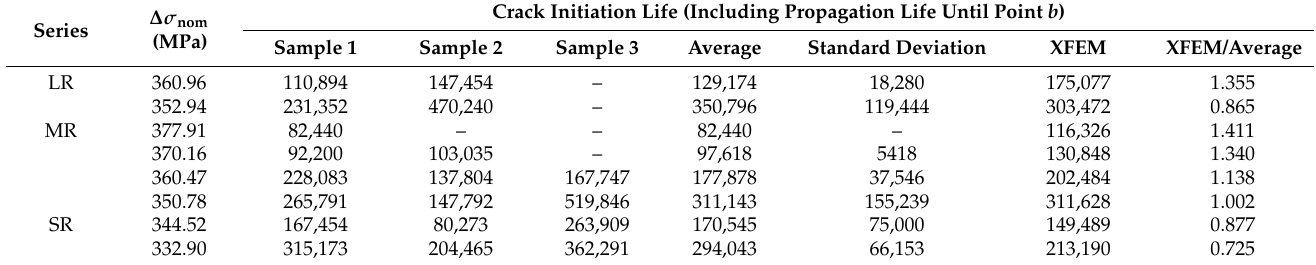
Table 4. Comparison of predicted and experimental fatigue crack initiation life.